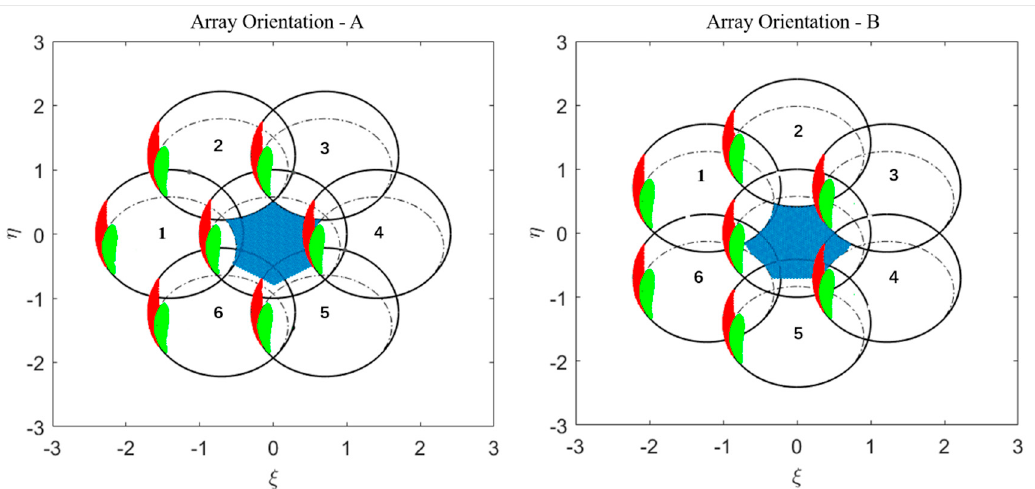
Figure 15. Illustration of the geometric place of the Sun’s positions in the IMR’s main sampling period and the corresponding six closest replicas, where the direct and reflected Sun are shown as red and green images, respectively. The black solid lines represent for the six replicas of the unit circle numbered as 1~6, and the black dashed lines are for the periodic repetition of the Earth’s disk. The EAF-FOV is labeled as blue images.